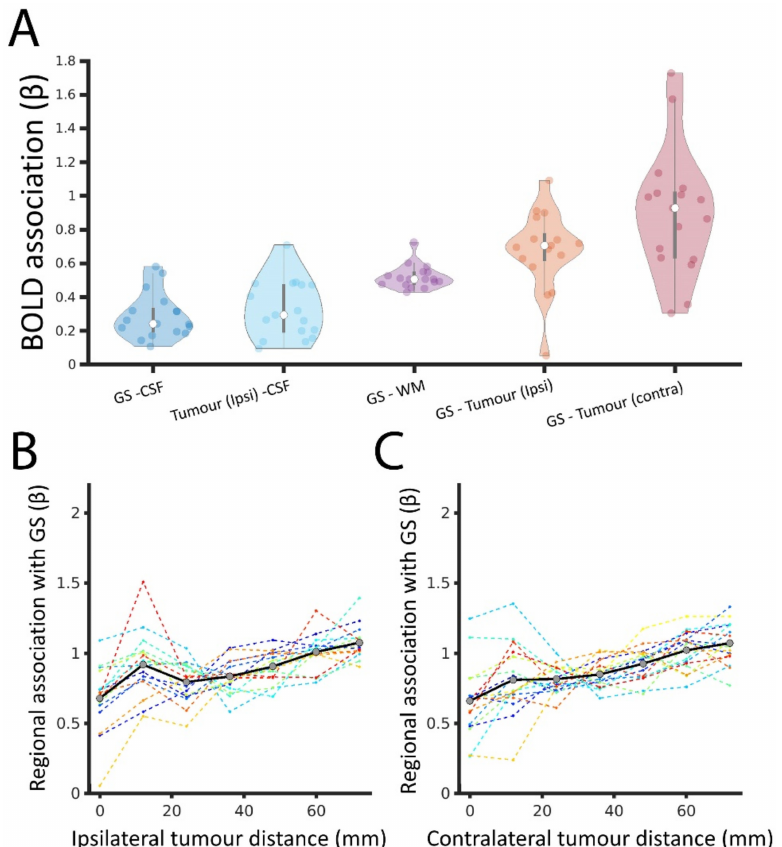
Figure 4. GS coupling with BOLD signal derived from tissue compartments. ( A ). Distribution of β across brain tumour patients (represented by individual dots) between BOLD signals derived from different tissue compartments: grey matter (that is, from which the GS is extracted), cerebrospinal fluid (CSF), white matter (WM), tumour (tumour ipsi) and cortical regions contralateral to the tumour (tumour contra). In the latter case, the β was calculated using a GS estimation that excluded the corresponding voxels contralateral to the tumour (to avoid overlapping between the independent and dependent variables). ( B ). The association, β , between the GS and non-tumour regions as a function of regional tumour distance (mm). ( C ). The association, β , between the GS and non-tumour regions as a function of regional distance (mm) to the contralateral tumour regions (i.e., zero represents homologous regions to the tumour in the contralateral, unaffected,